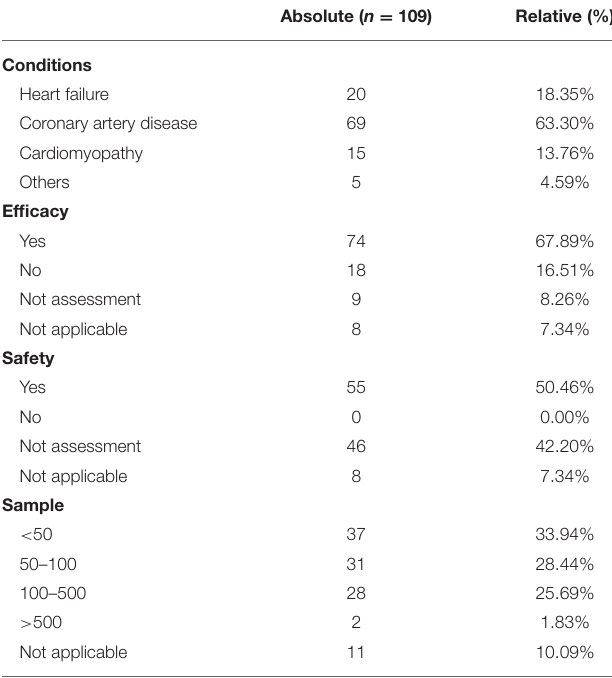
TABLE 8 | Publication status of trials.